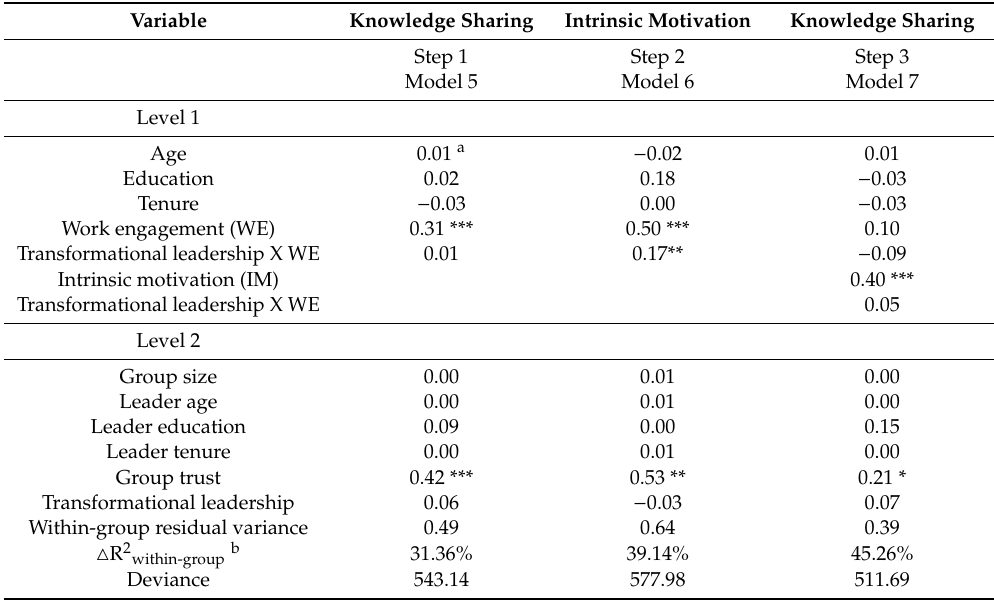
Table 3. Results for testing mediated moderation by transformational leadership.